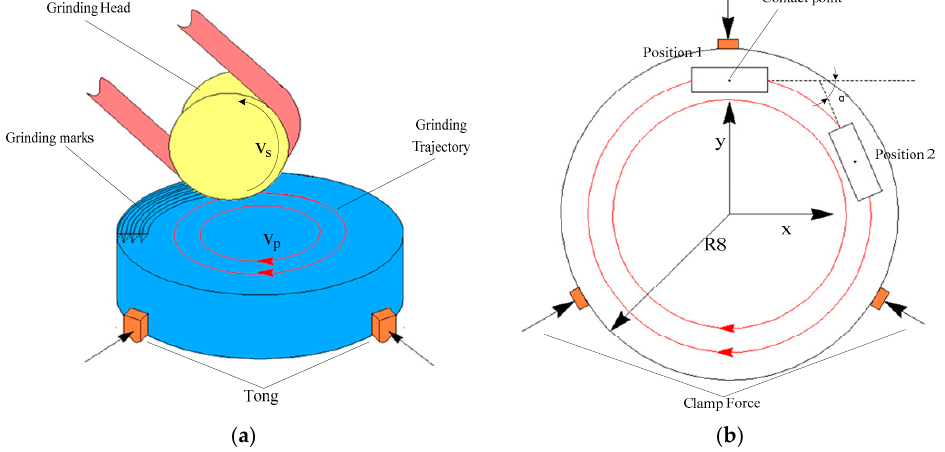
Figure 2. Circular track grinding. ( a ) Sketch of circular grinding; ( b ) Diagrammatic drawing of circular track. Crystals 2019 , 9 , x FOR PEER REVIEW